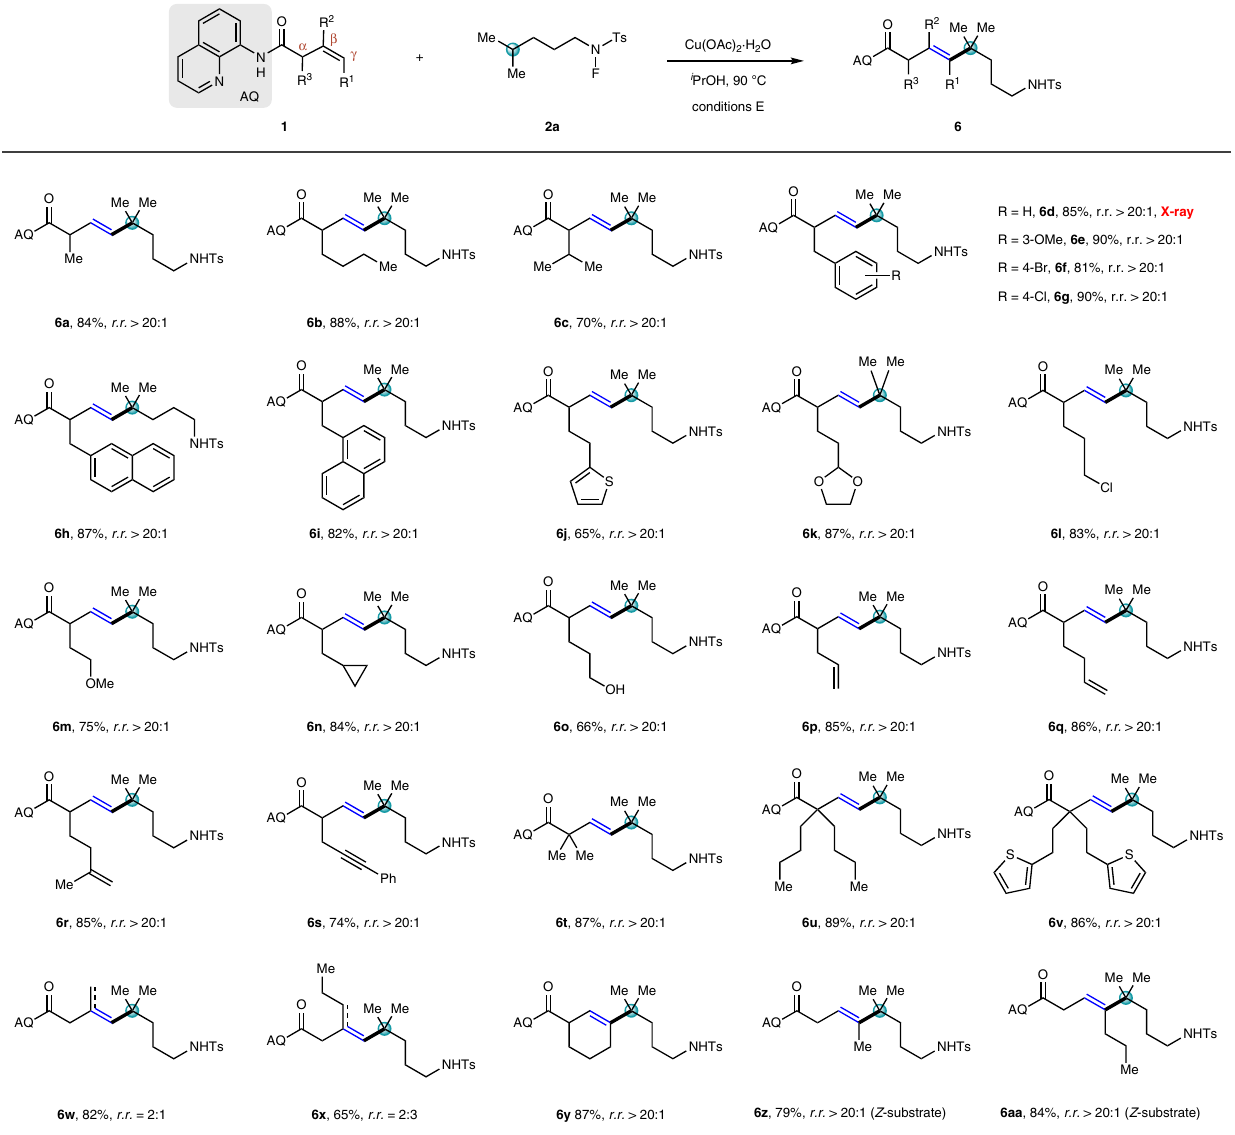
Fig.5|Substratescopeofalkenesforvinylcouplingreactions. ConditionsE: 1 (0.20mmol), 2a (0.50mmol),andCu(OAc) 2 ·H 2 O(0.02mmol)in i PrOH(3.0mL)at90°C for 2h. Isolated yields are shown. E / Z is >20:1 if not stated